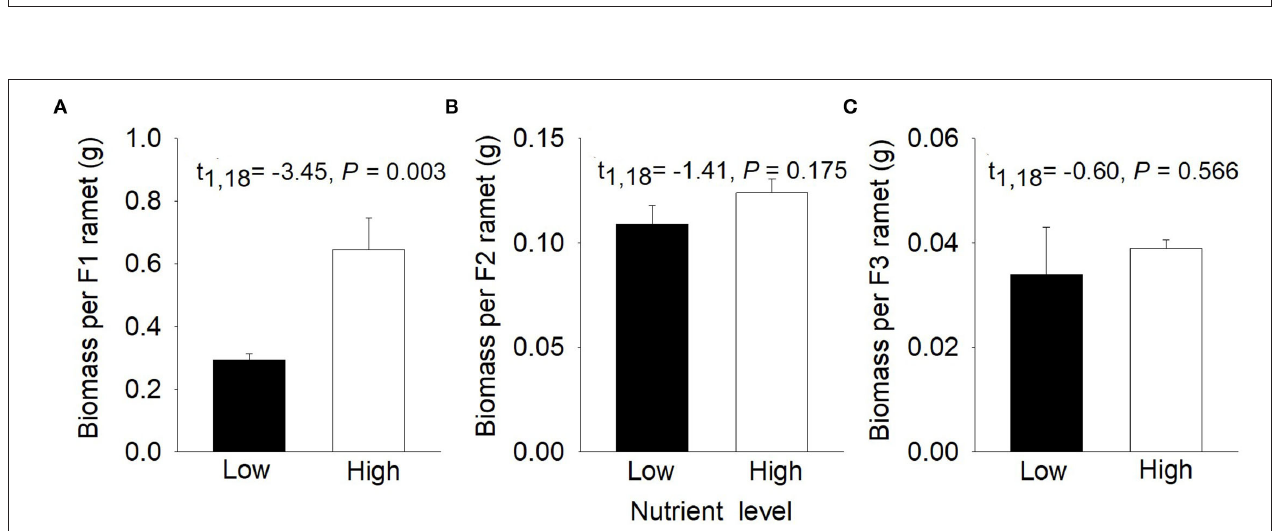
FIGURE 2 | Effects of nutrient level (low vs. high) on (A) biomass per F1 ramet, (B) biomass per F2 ramet, and (C) biomass per F3 ramet of Pistia stratiotes in the first phase. Bars show means + SE ( n = 10).